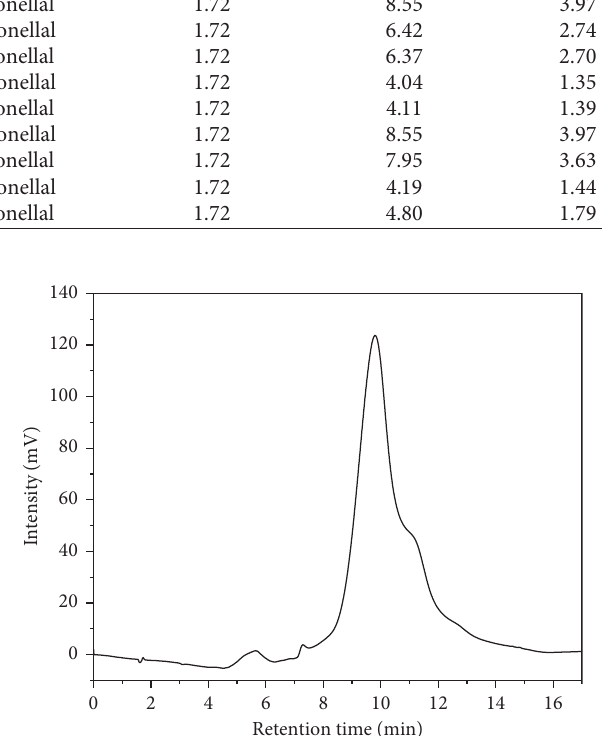
Figure 9: Chromatogram of rac -citronellal separation using MMIP B column. Mobile phase (A) H 2 O and mobile phase (B) acetonitrile 90% in (A), gradient elution: 70%–75% B for 8 mins, 75%–85% for 9 mins; detection wavelength at 253nm; flow rate